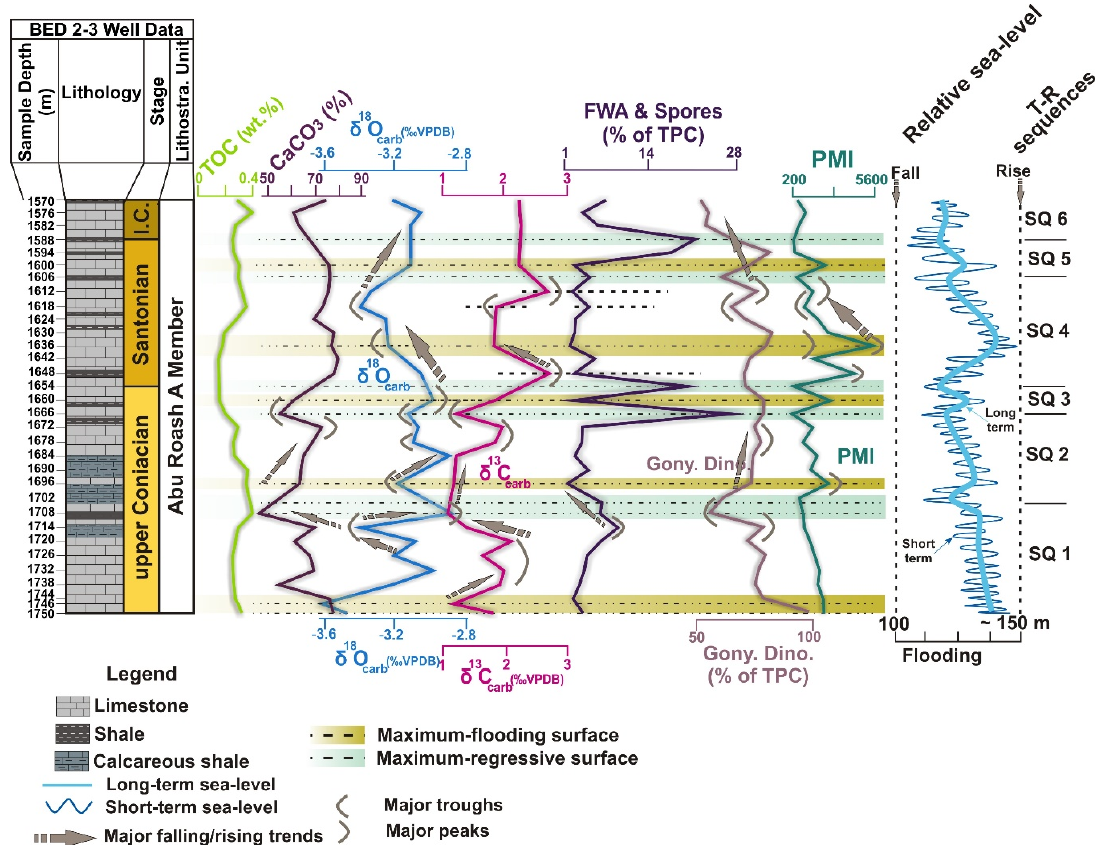
Figure 7. Bulk carbonate stable carbon and oxygen isotope profiles along with specific palynomorphs parameters used to reconstruct the relative sea level during deposition of the Abu Roash A Member. FWA = Freshwater algae, Gony. Dino. = Gonyaulacoid dinocysts, PMI = Palynological marine index.